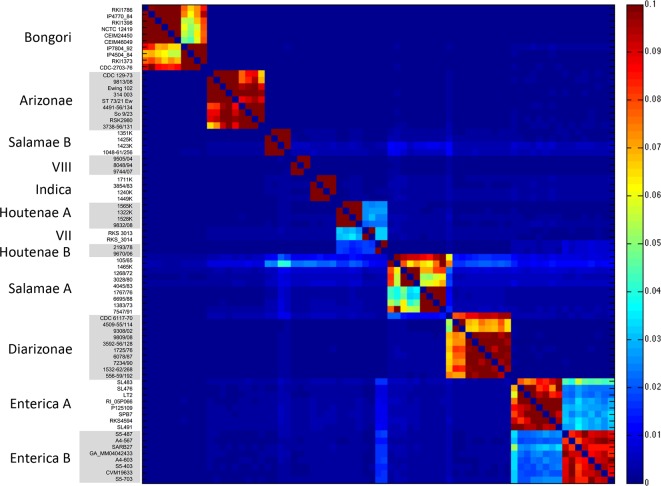
Coancestry matrix of 73
Salmonella
 genomes, computed using ChromoPainter. Each cell of the coancestry matrix is coloured according to the corresponding coancestry value (colour scale on the right), i.e. the amount of genetic material copied from a donor genome (columns) to a recipient genome (rows), with dark blue corresponding to 0 % and dark red corresponding to 10 %. The 73 strain names as well as the 12 phylogroups are indicated on the left.